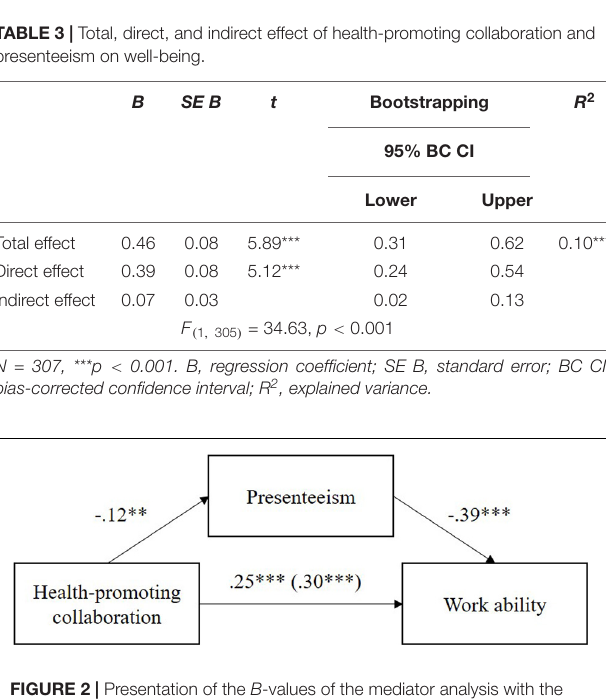
FIGURE 2 | Presentation of the B -values of the mediator analysis with the criterion work ability. The B -value of the total effect is given in parentheses. ***p < 0.001, ** p < 0.01.